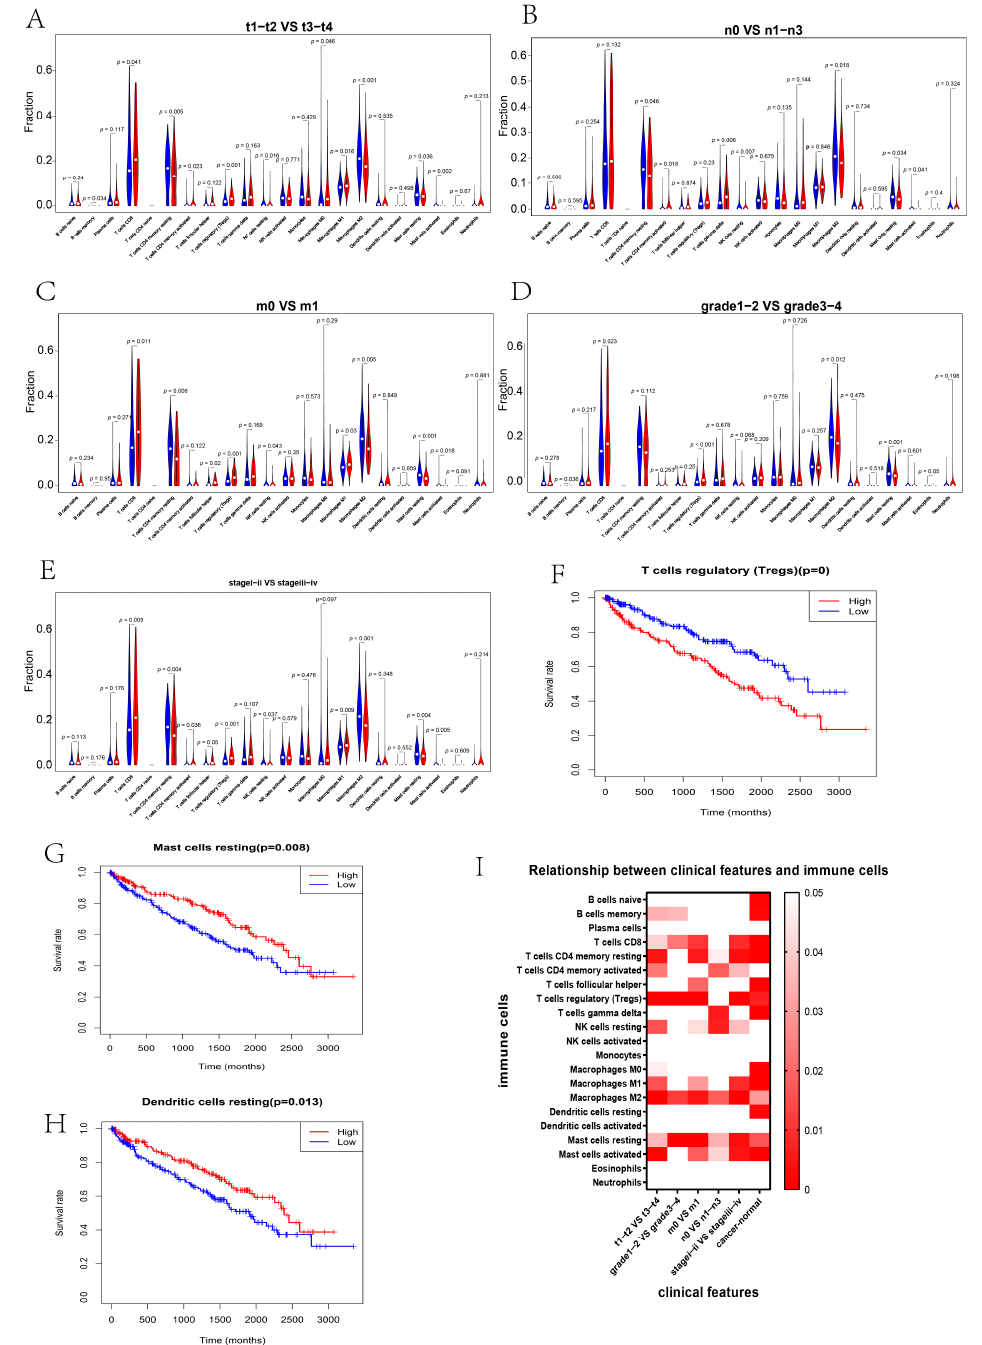
Figure 9. The correlation between immune infiltration and clinicopathological features. ( A – E ) Violin box plots display the immune infiltration of 22 immune cells between t1–t2 and t3–t4 ( A ), n0 and n1–n3 ( B ), m0 and m1 ( C ), grade 1–2 and grade 3–4 ( D ), and stage I–II and stage III–IV ( E ). ( I ) The heatmap of the p value depicts the difference between clinicopathological features and immune infiltrations of 22 immune cells. Red indicates that the difference in immune infiltration is significant. The more significant the difference, the darker the color. ( F – H ) The K–M curves of OS for high and low immune infiltration of regulatory T cells (( F ), p < 0.00001), resting mast cells (( G ), p = 0.008), and resting dendritic cells (( H ), p =